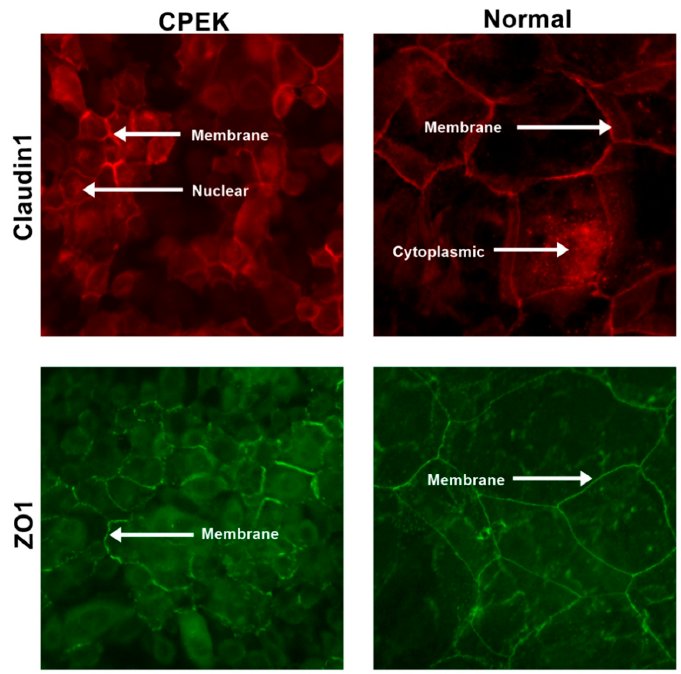
Figure 9. Representative images to show the location of the staining for both claudin and ZO-1 in both canine progenitor epidermal keratinocyte (CPEK) cells and normal keratinocytes. Staining is in red for claudin and green for ZO-1. Images were taken at 40x.